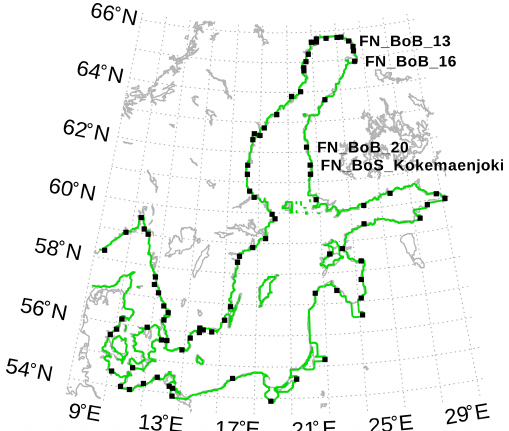
Figure 1. Location of model rivers (black squares). The green line is the coastline of the 3nm model. We refer to the labeled river later in the text. The map was created using the software package GrADS 2.1.1.b0 (http://cola.gmu.edu/grads/, last access: 6 August 2021), using published bathymetry data (Seifert et al., 2008).